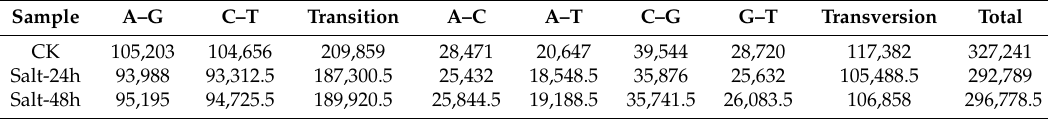
Figure 4. Bar plot of simple sequence repeats (SSR) distribution. The X -axis represents the SSR type, and the Y -axis represents the corresponding number of SSRs. Table 4. Integrated results of each sample single nucleotide polymorphism (SNP).